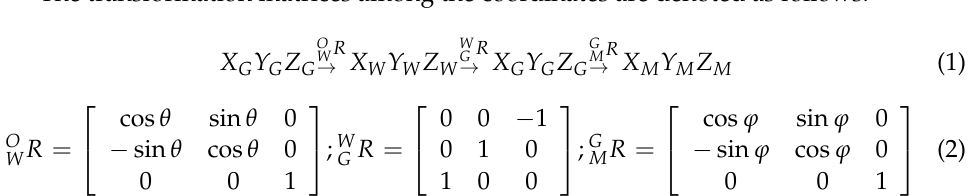
The coordinate attached to a hand { W } : X W Y W Z W located at a central point of the wrist joint; Z w coincides with Z 0 and deviates at θ angle from X 0 Y 0 Z 0 . The gimbal frame { G } : X G Y G Z G has a precession axis Z intersecting with the Y axis (cid:0) (cid:1) x p , y p , z p at its central point . The reference coordinate { M } : X M Y M Z M has the same central point as X G Y G Z G but deviates at a ϕ angle from its location The transformation matrices among the coordinates are denoted as follows.